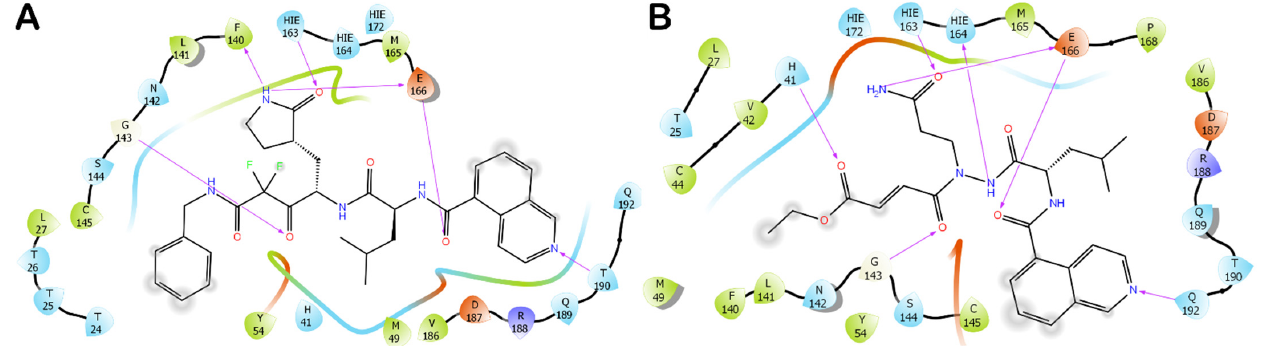
Figure 5. Detailed binding mode of compound 6 (panel A ) and compound 7 (panel B ). Pictures were generated by ligand interaction diagram available in Maestro (Maestro, Schrödinger LLC, release 2020-3).